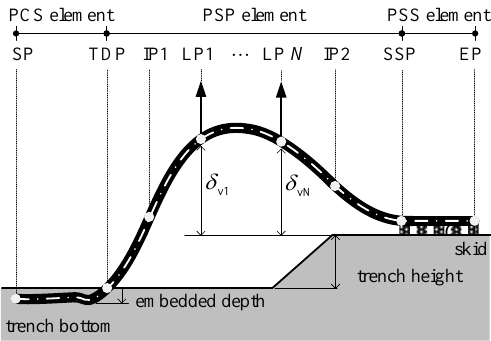
Figure 3. Segmental pipeline model in the vertical(x-y) plane.